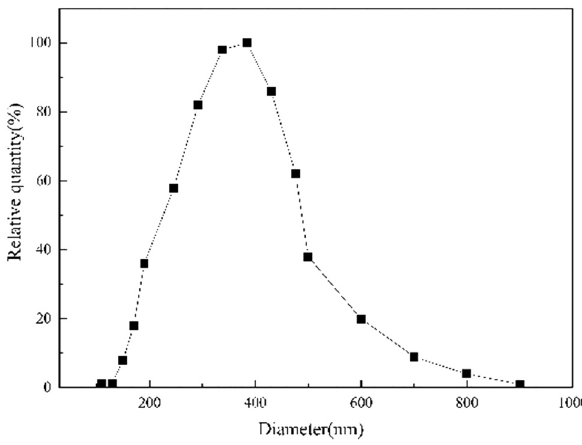
Figure 1: The particle size distribution of indigo dispersed in color